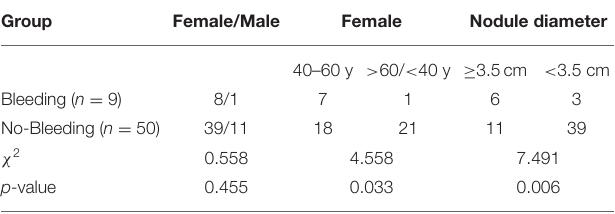
TABLE 2 | Risk factors of intracystic hemorrhage with cystic thyroid nodules (n). Group